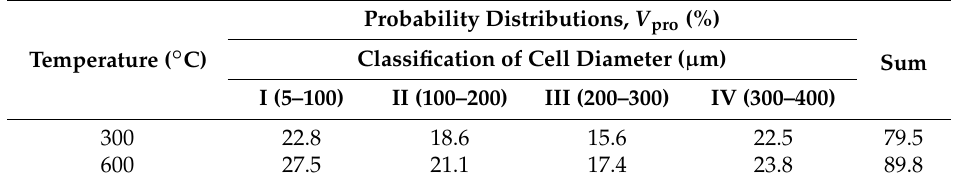
Table 1. Percentage probability distributions of cell volume.